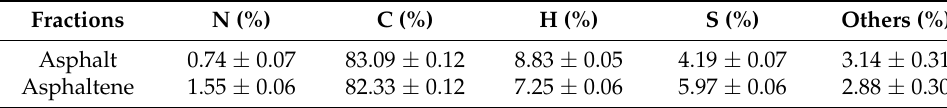
Table 2. Mass percentage of elements from elemental analysis.